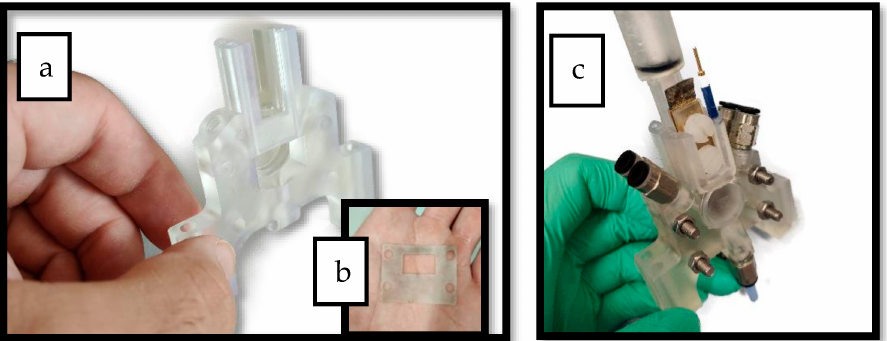
Figure 4. ( a ) Photo of one of the reactor’s compartments after printing. ( b ) Silicon sheet used to seal the gap in between the two compartments. ( c ) Photo of the final assembled reactor after printing.